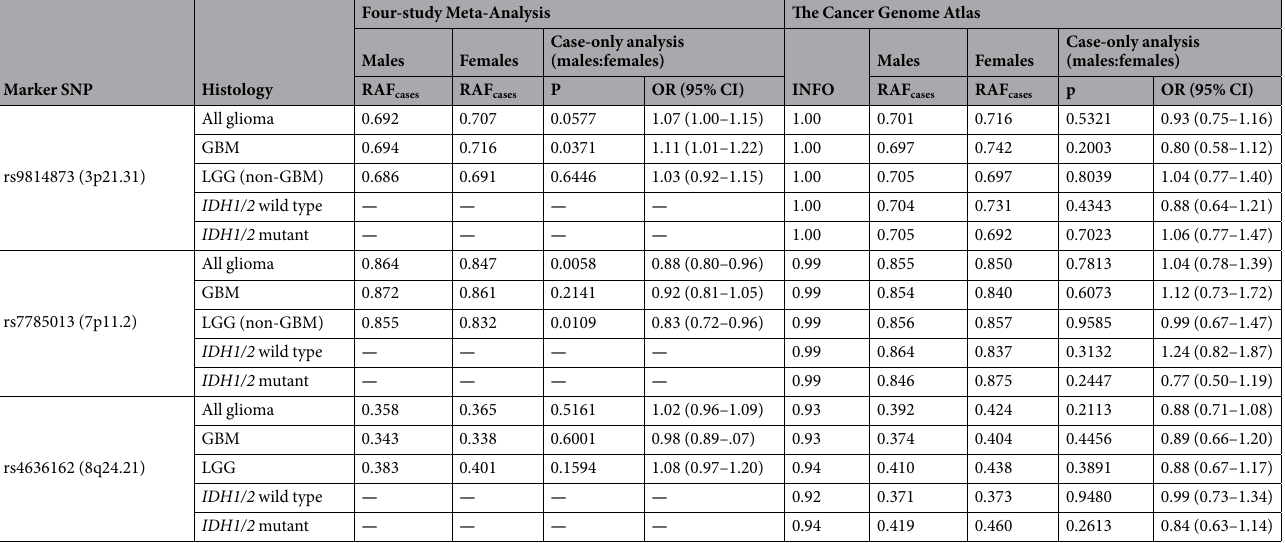
Table 4. Risk allele frequencies (RAF) Case-only odds ratios, 95% confidence intervals (95% CI), and p values for marker SNPs from four study meta-analysis and the Cancer Genome Atlas genotyping